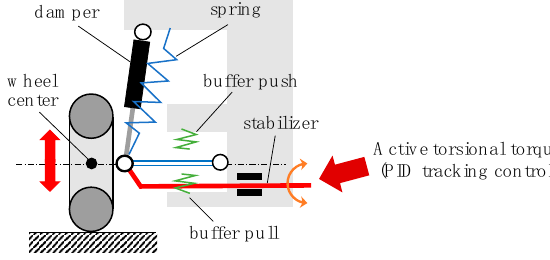
Figure 4. Torsional torque is applied to stabilizer bar.